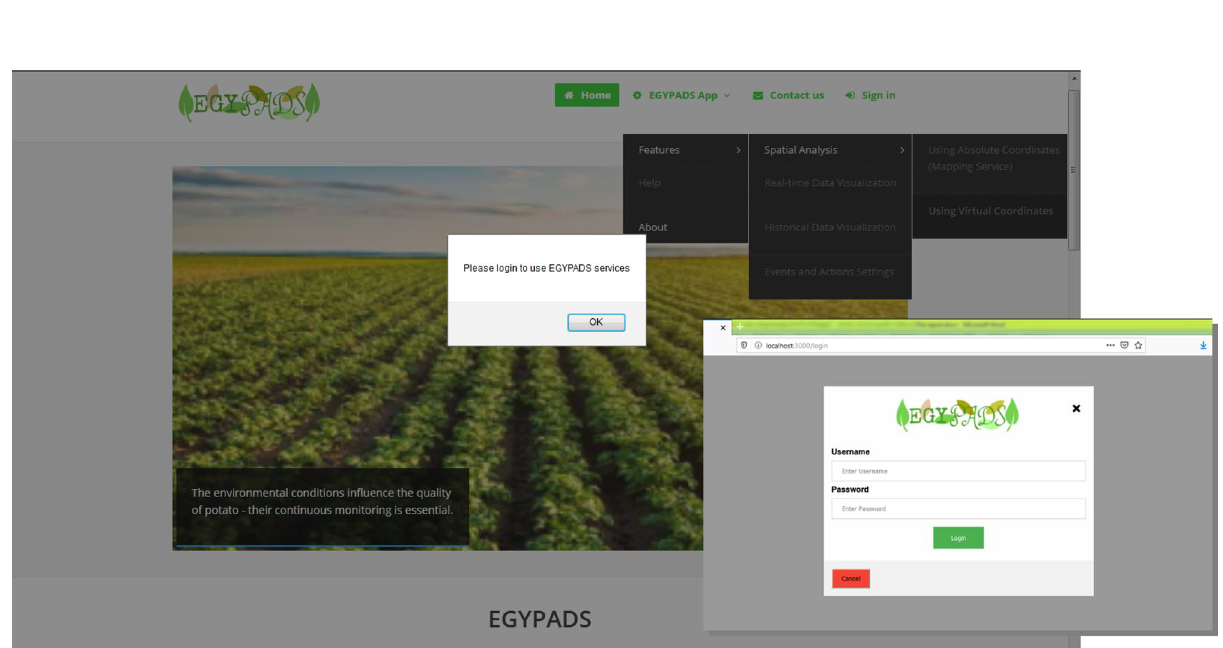
Figure 10. Application homepage and login page